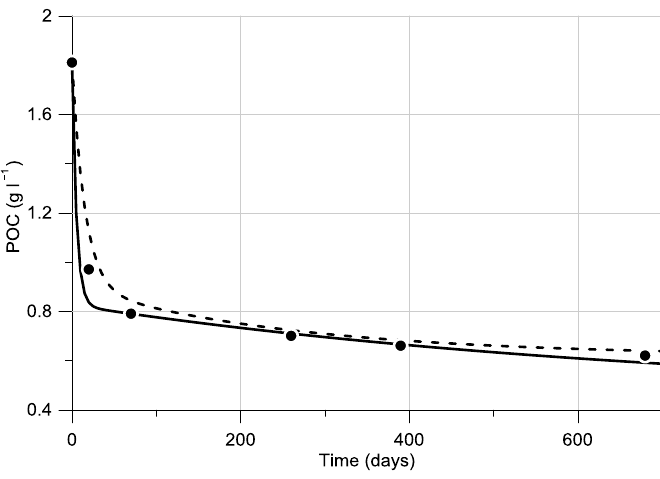
Figure 7. Measured POC from degradation experiments with fresh phytoplankton (black circles) with a 3-G model fit from Westrich and Berner (1984) (dashed line; k 0 = 24yr − 1 , k 1 = 1.4yr − 1 , k 2 = 0yr − 1 and f 0 = 0.50, f 1 = 0.16, f 2 = 0.34, R 2 = 0.98). The solid line shows the result with parameters derived in this study ( k 0 = 70yr − 1 , k 1 = 0.5yr − 1 , k 2 = 0.001yr − 1 and f 0 = 0.54, f 1 = 0.21, f 2 = 0.25, R 2 =